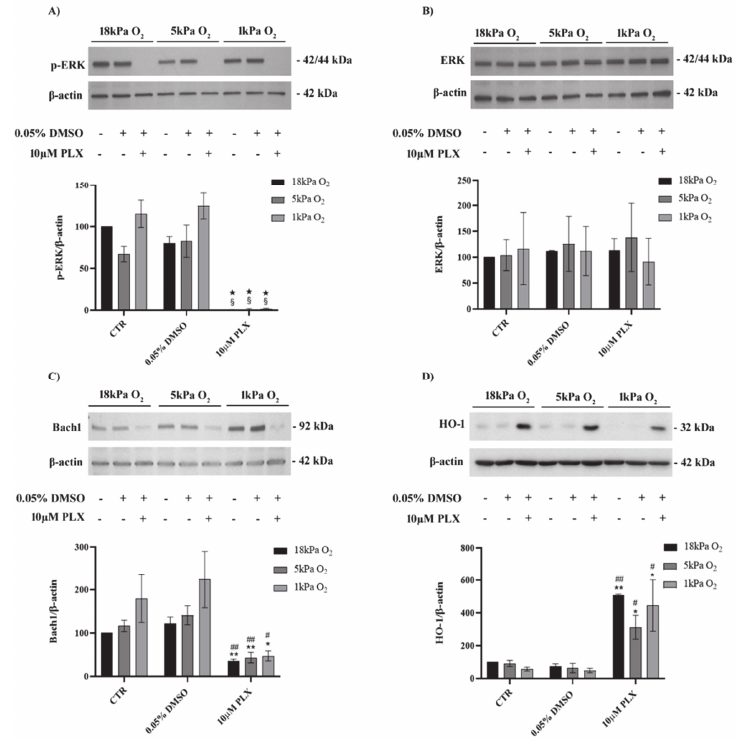
Figure 1. Immunoblot analysis of pERK ( A ), total ERK ( B ), Bach1 ( C ) and HO-1 ( D ). MeOV-1 cells were adapted for 5 days to 18 kPa, 5 kPa or 1 kPa O 2 and then treated with 10 µ M PLX4032 (or 0.05% DMSO) for 24 h. β -actin was used as loading control. Immunoblots are representative of 3–4 independent experiments. Data denote mean ± S.E.M., n = 3–4 independent cell cultures, § p < 0.001 vs. CTR; (cid:70) p < 0.001 vs. DMSO; (cid:70)(cid:70) p < 0.01 vs. CTR; # p < 0.05 vs. DMSO; ## p < 0.01 vs.